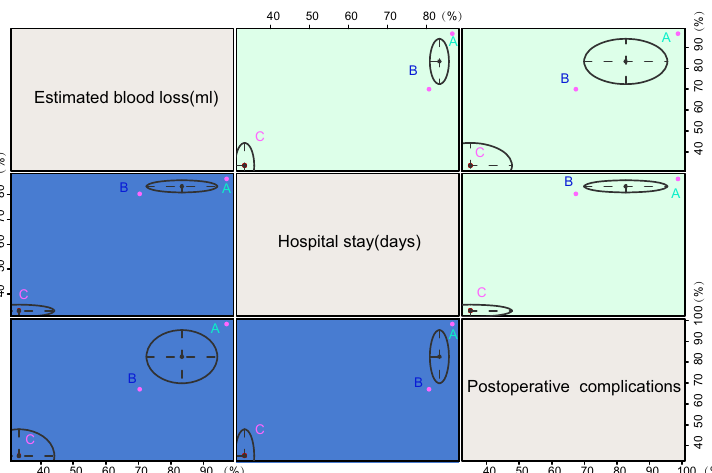
Fig 4. Cluster analysis diagram of estimated blood loss (ml), hospital stay (days) and postoperative complications of RRH, LRH and ORH in the treatment of early-stage CC. Note: A = RRH (robotic radical hysterectomy); B = LRH (laparoscopic radical hysterectomy); C = ORH (open radical hysterectomy).